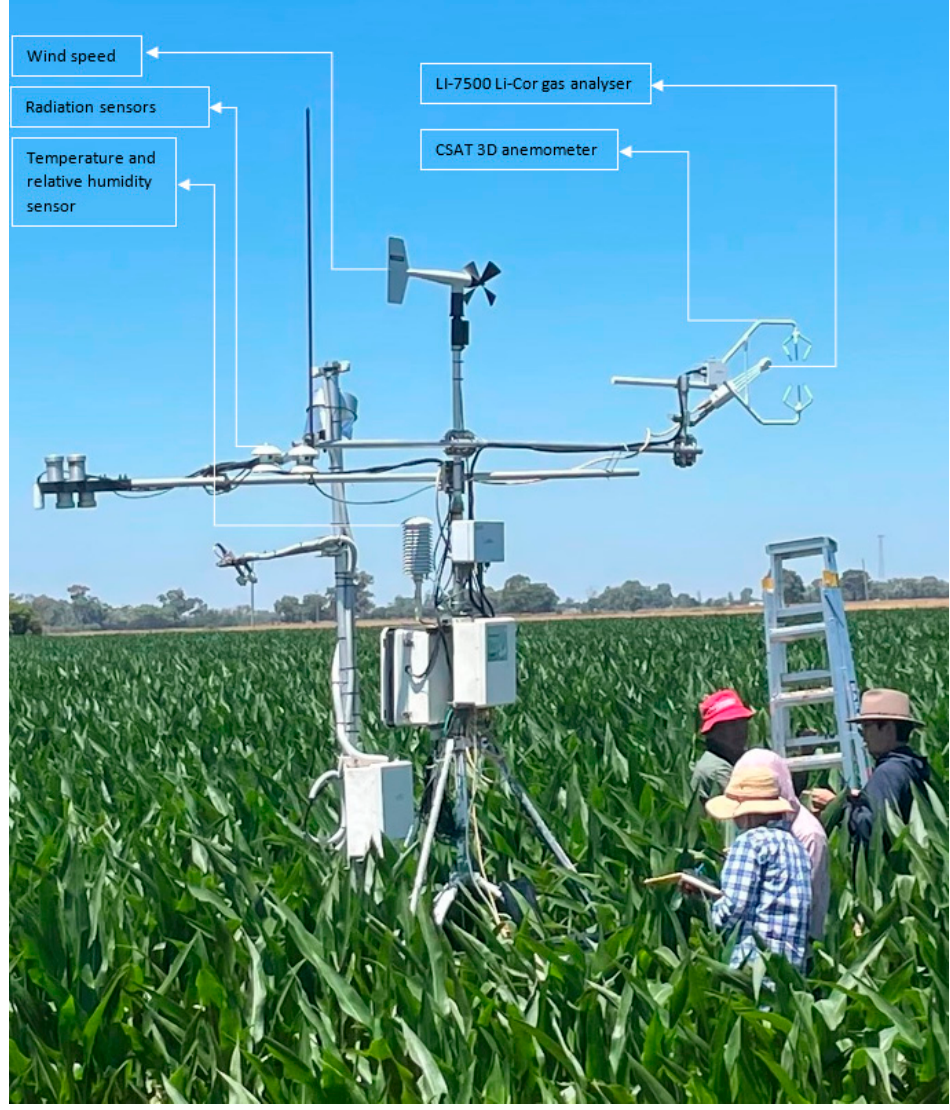
Figure 1. The eddy ‐ covariance system and the weather station for monitoring fluxes and weather conditions at the study field. The purposes for different parts of the monitoring stations are labelled. Note that the CSAT 3D anemometer was measuring the 3D wind speed and direction, while the wind speed sensor on the top provided a second set of wind speed measures and the dominant direction within the horizontal plane for validation. The soil moisture down to 90 cm and the canopy temperature and NDVI were also monitored but observations were not used in this